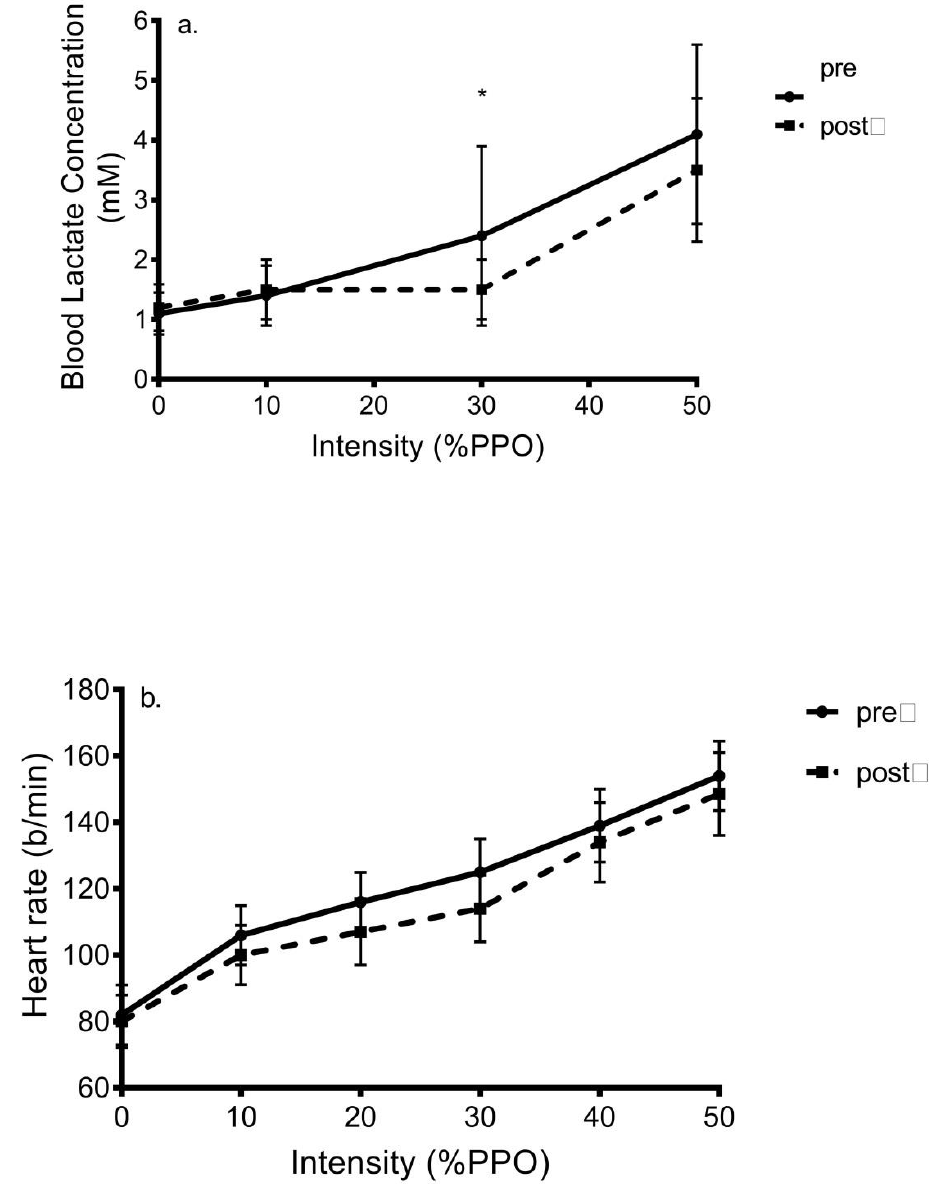
Figure 3. Change in ( a ) blood lactate accumulation and ( b ) heart rate during progressive exercise in response to low-volume HIIT in inactive women (mean ± SD). * = p < 0.05 versus pre-training